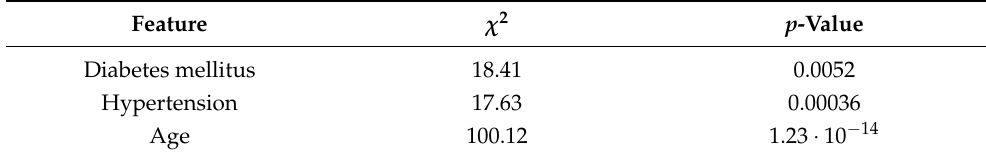
Table 6. Hypothesis testing results for Severity-outcome.